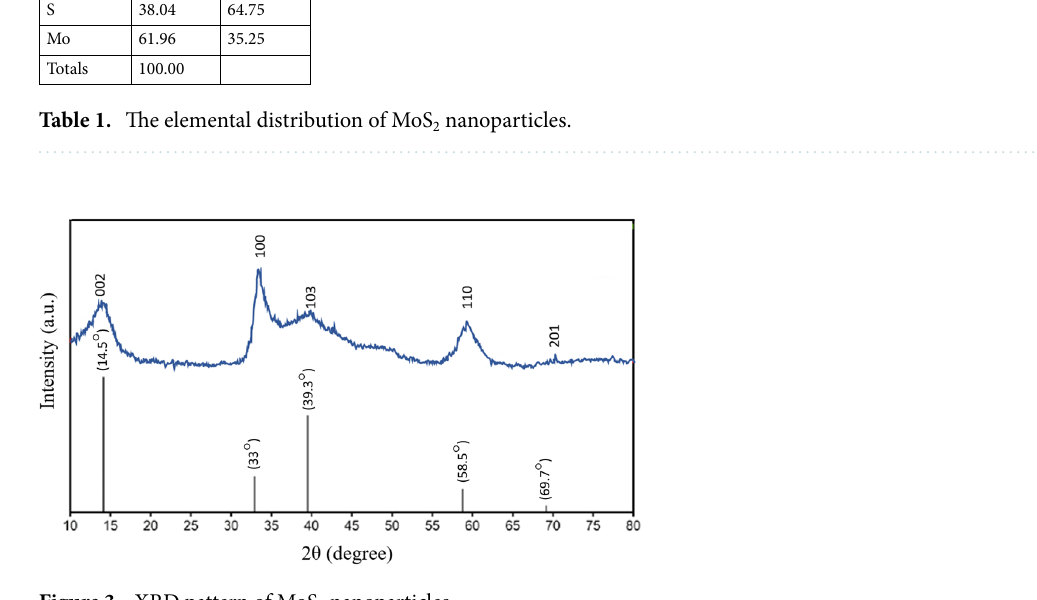
Figure 3. XRD pattern of MoS 2